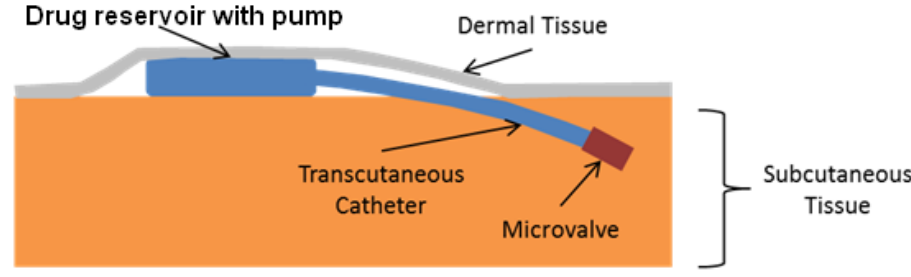
Figure 1. Illustration of a drug delivery device with a separated reservoir embedded under dermal tissue. The drug was pumped through the catheter to the target site where a microvalve was used to regulate the flow rate of the